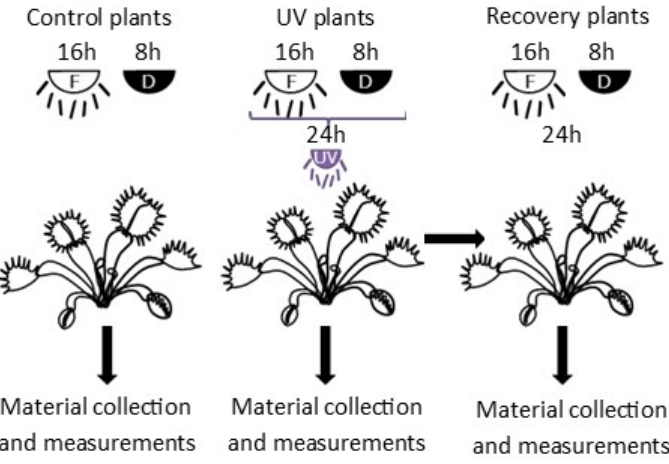
Figure 1. Scheme of experiment. F—fluorescent light (290 µ mol · m − 2 s − 1 PPFD); D—dark; UV—UV radiation (50 µ mol · m − 2 · s − 1 PPFD).